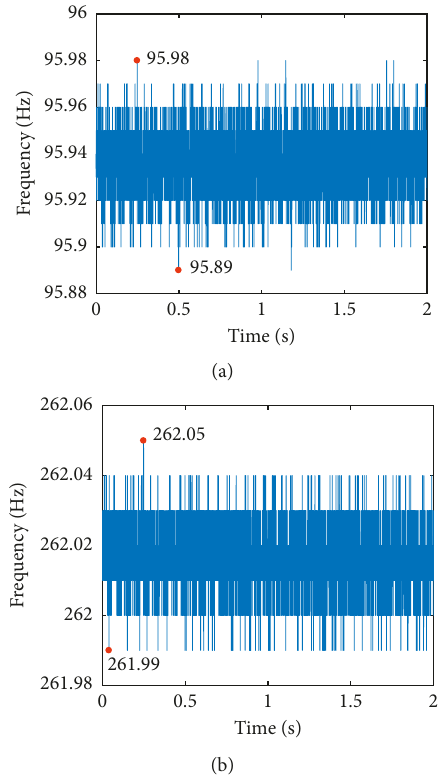
Figure 12: First two instantaneous frequencies of tensioned ball screw during the cutting process.